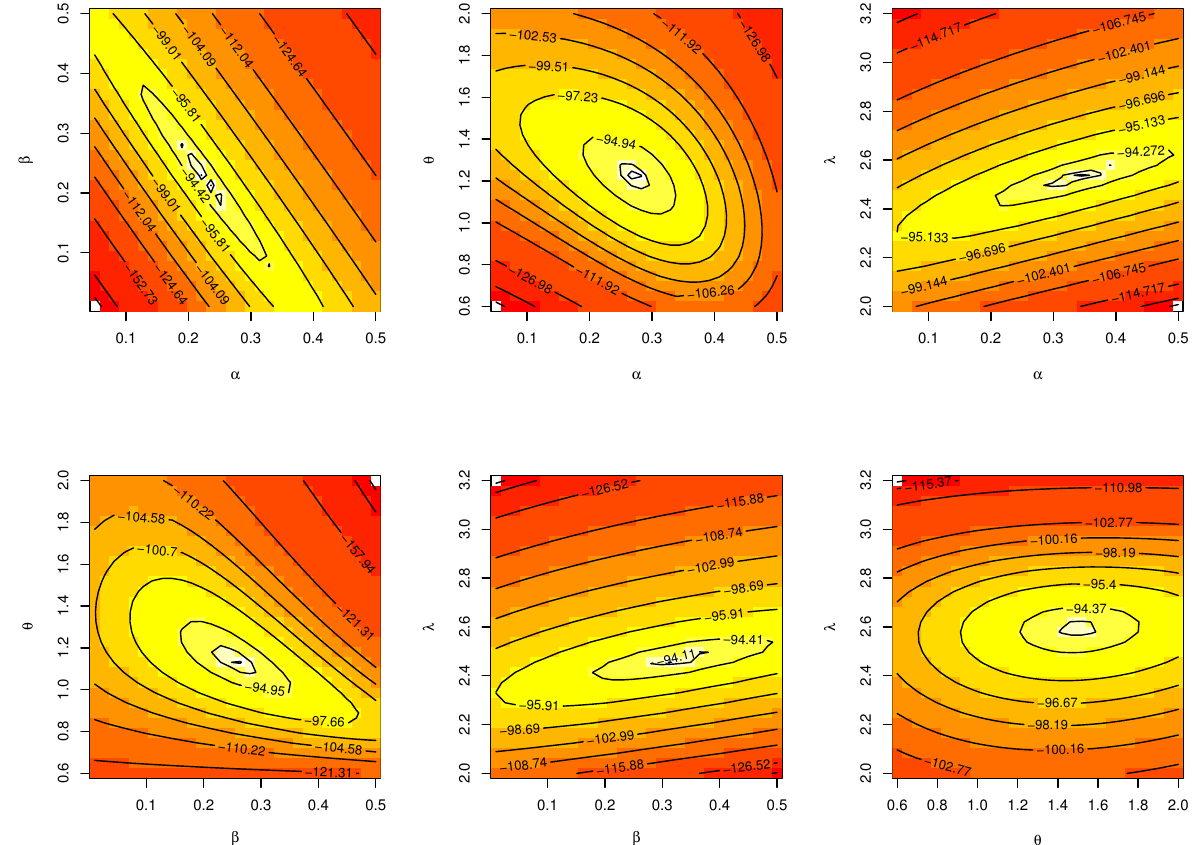
Figure 14. Contour plot for parameters of TLMW model for Guinea Pigs